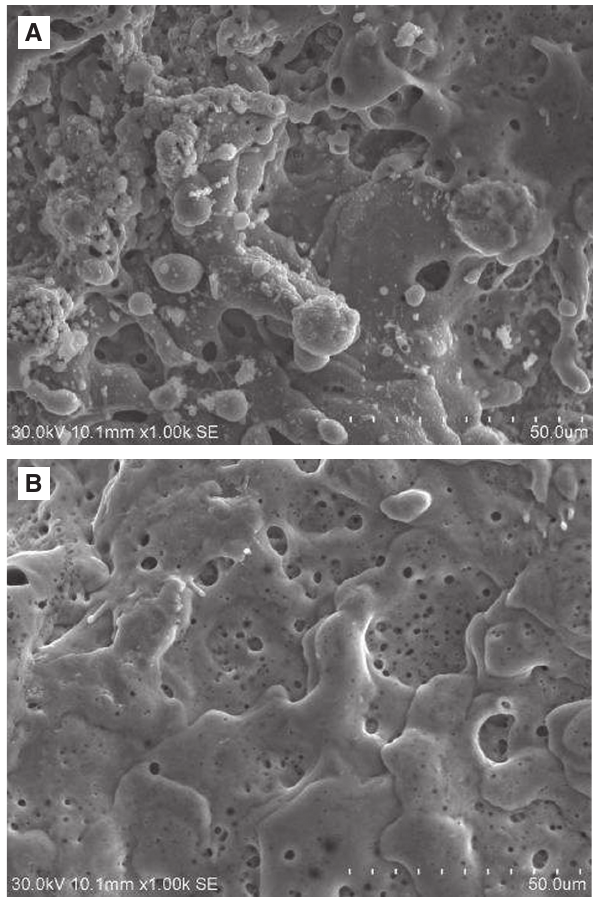
Figure 4 Arc erosion microarea surface of (A) anode and (B) cathode of the